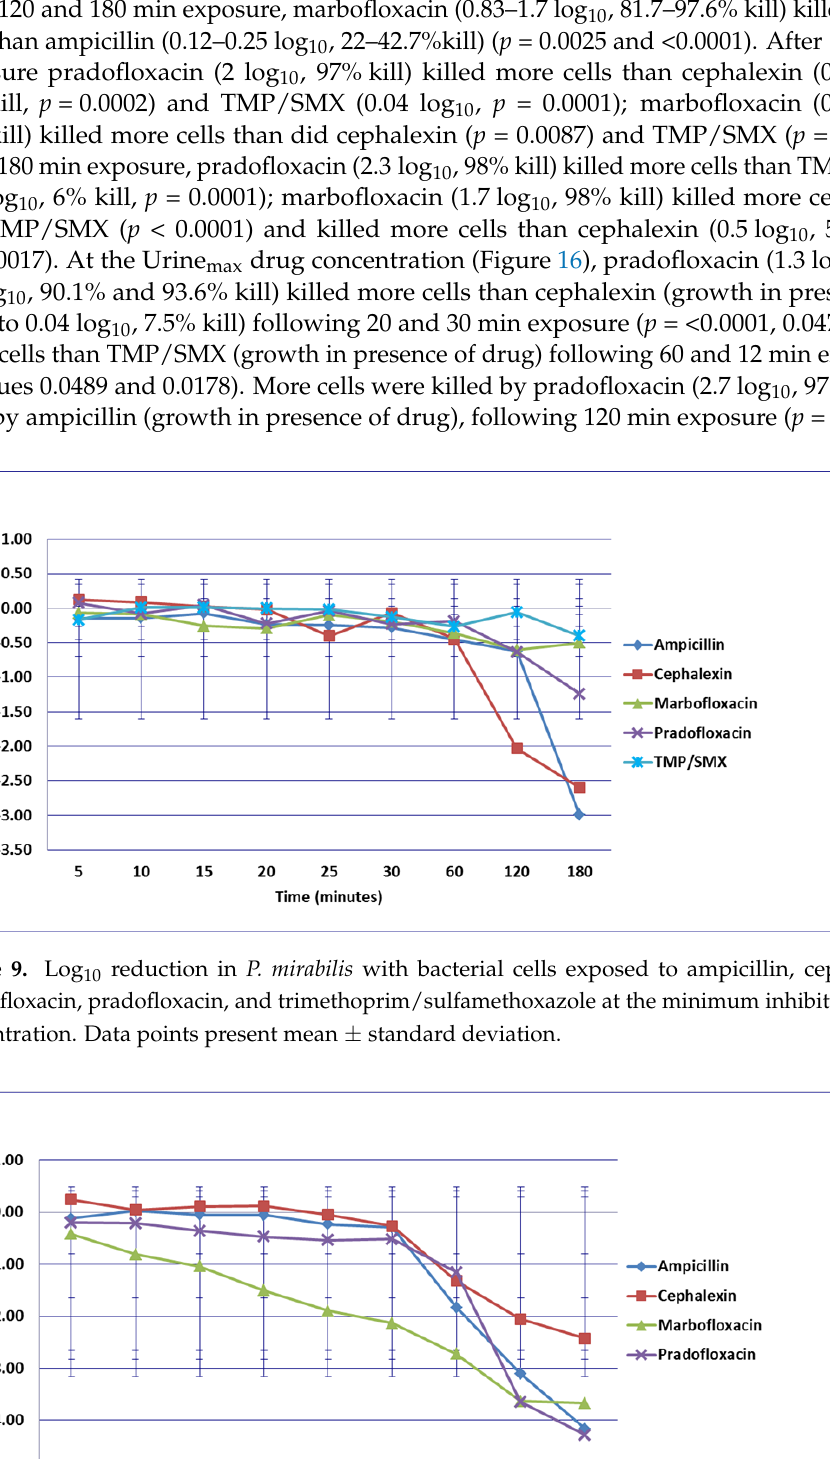
Figure 10. Log 10 reduction in P. mirabilis with bacterial cells exposed to ampicillin, cephalexin, mar- bofloxacin, and pradofloxacin at the mutant prevention drug concentration. Marbofloxacin vs. am- picillin at 15, 20, 25, and 30 min, p values from 0.0006 to 0.0214. Data points present mean ± standard deviation.